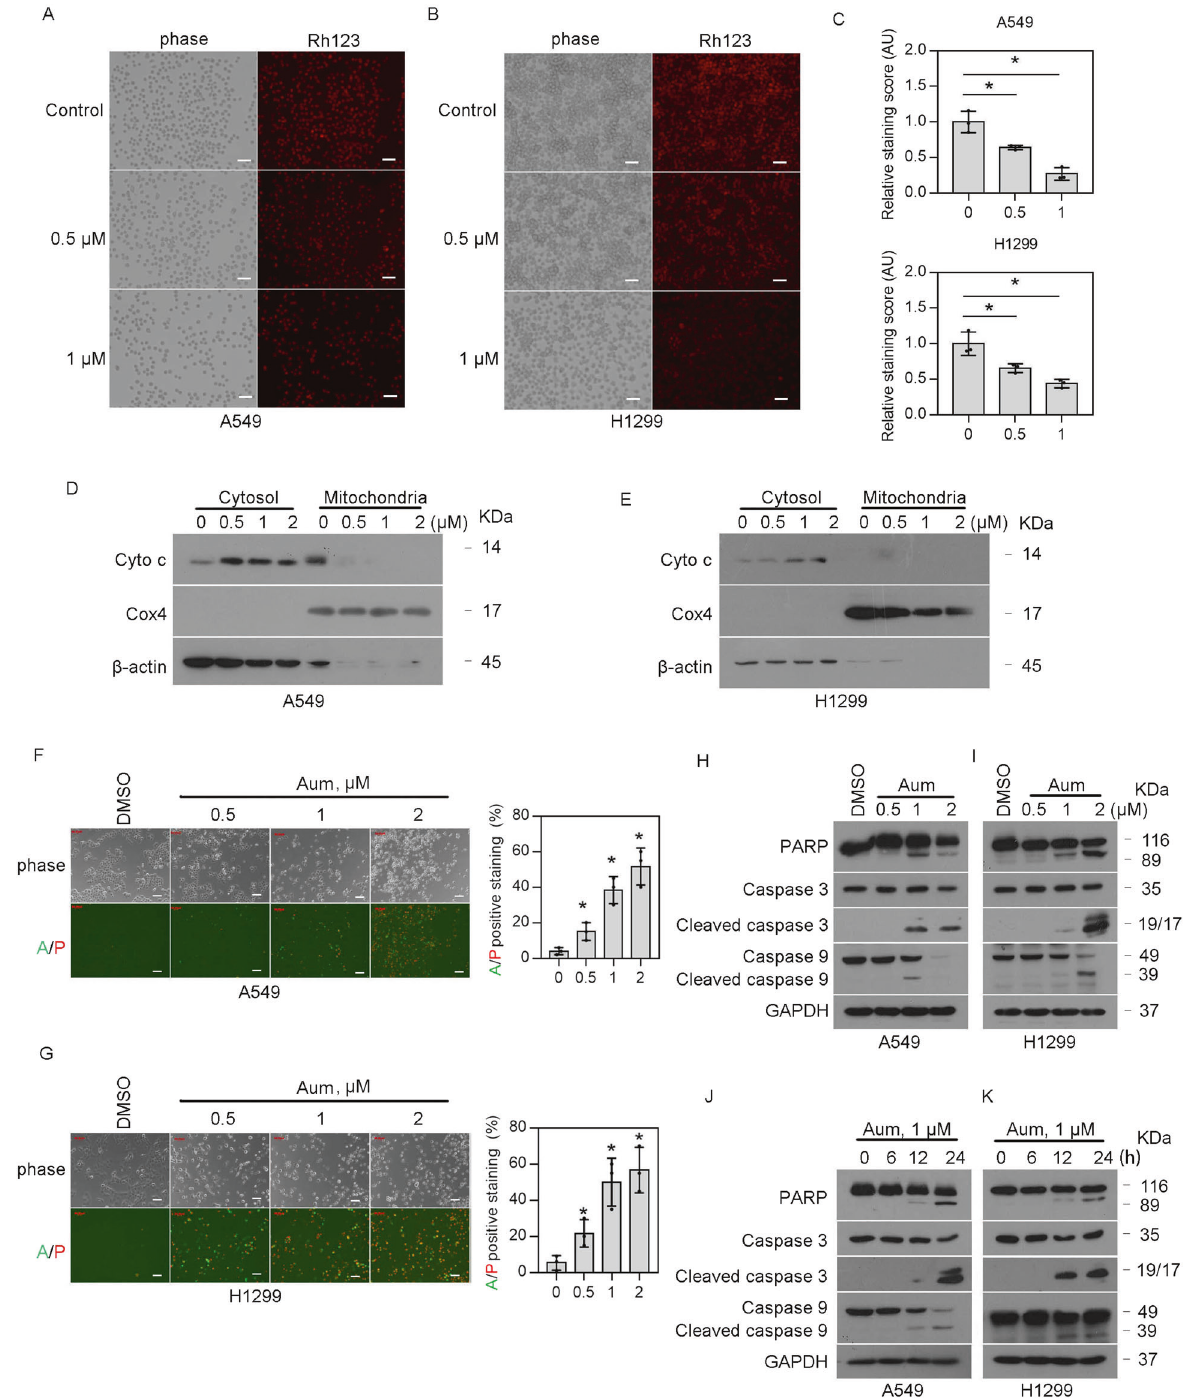
Fig. 3 Aumdubin induces mitochondrial apoptosis in A549 and H1299 cells. A – C Aumdubin induces downregulation of mitochondria membrane potential. A549 and H1299 cells were treated with aumdubin for 12 h, and then mitochondrial membrane potential were detected by rhodamine-123 (Rh123) staining, following imaged with a fl uorescence microscope. The representative images ( A , B ) and relative quanti fi cation ( C ) were shown. Scale bars, 50 µm. Mean ± s.d. ( n = 3). * P < 0.05. D , E Aumdubin induces the release of cytochrome c from mitochondria into cytoplasm. A549 ( D ) and H1299 ( E ) cells were treated with various concentrations of aumdubin for 24 h. Cytochrome c (Cyto c) was analyzed with western blotting. COX4 and β -actin were used as loading control for mitochondria and cytosol, respectively. F , G Aumdubin induces apoptosis. A549 ( F ) and H1299 ( G ) were treated with different doses of aumdubin (Aum) for 24 h, then apoptotic cells were detected by Annexin V-FITC/propidium iodide (PI) double staining, and the stained cells were recorded using an inverted fl uorescence microscope. Scale bars, 50 µm. The relative quanti fi cation of apoptotic cells were shown. H – K Aumdubin induces the activation of caspases. A549 and H1299 cells were treated with either various concentrations of aumdubin for 24 h ( H , I ) or the indicated concentrations of aumdubin for various time ( J , K ). PARP and caspase-3, and -9 cleavage were analyzed with western blotting. GAPDH was used as a loading control.